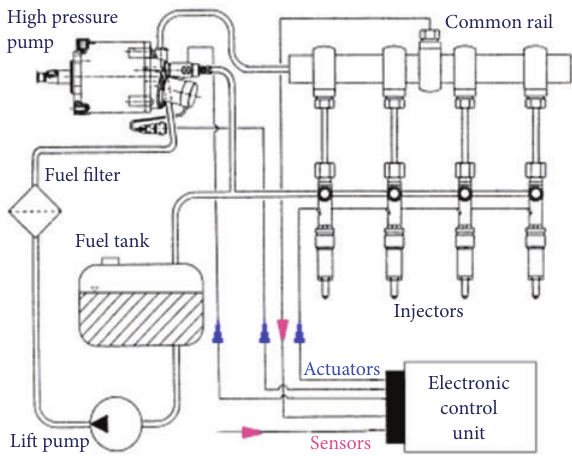
Figure 1: Schematic of the common-rail injection system.